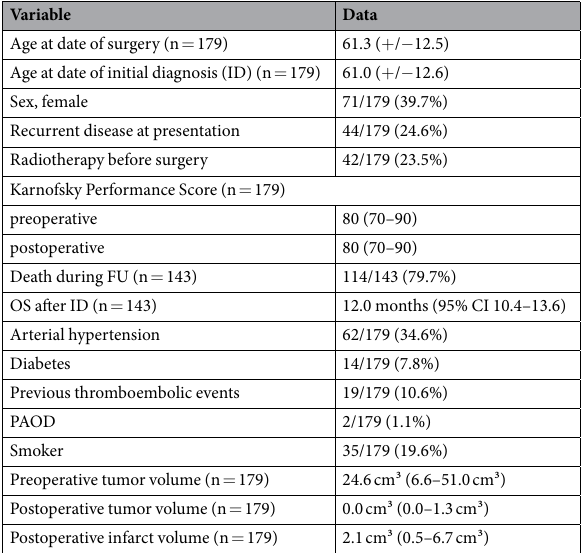
Table 1. Patient characteristics and volumetric measurements. normally distributed variables shown as mean + / − standard deviation, non-normally distributed as median (interquartile range). f, female; m, male; FU: follow up; OS: overall survival, ID: initial diagnosis; PAOD: peripheral arterial occlusive